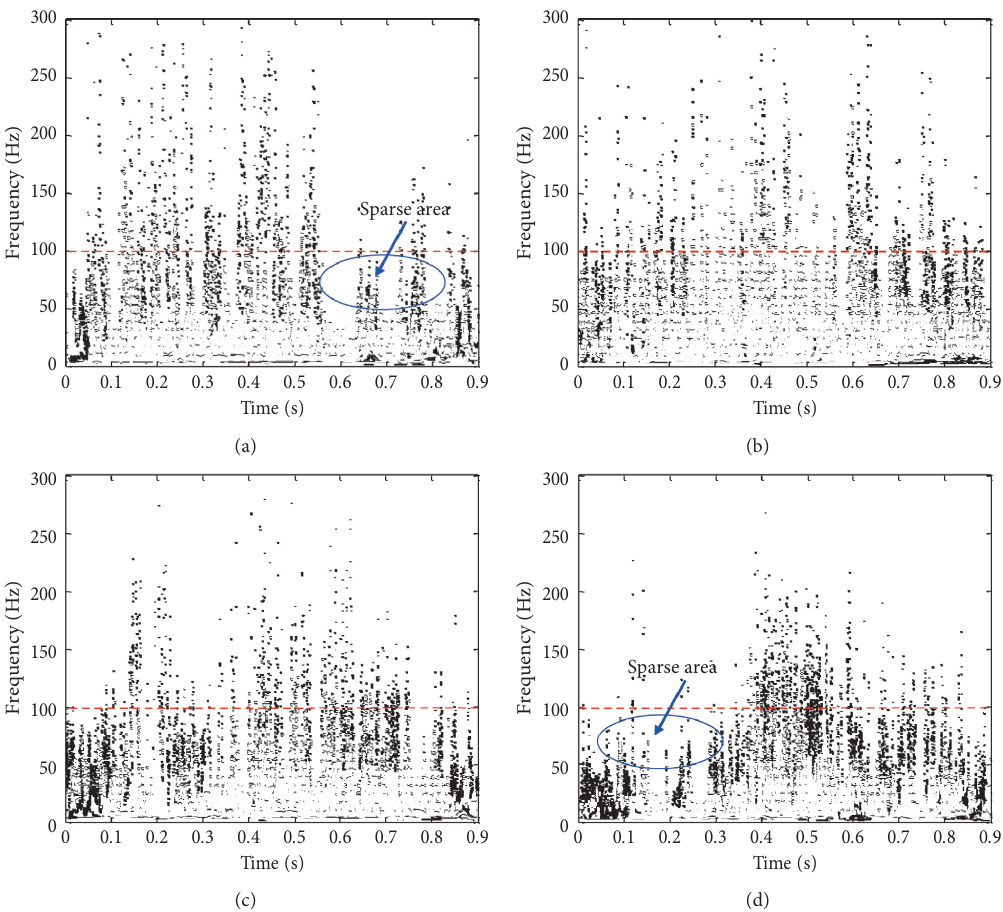
Figure 9: Hilbert energy spectra. (a) Conventional charge structure. (b) Water interval charge at both ends. (c) Water interval charge at the orifice. (d) Water interval charge at the hole